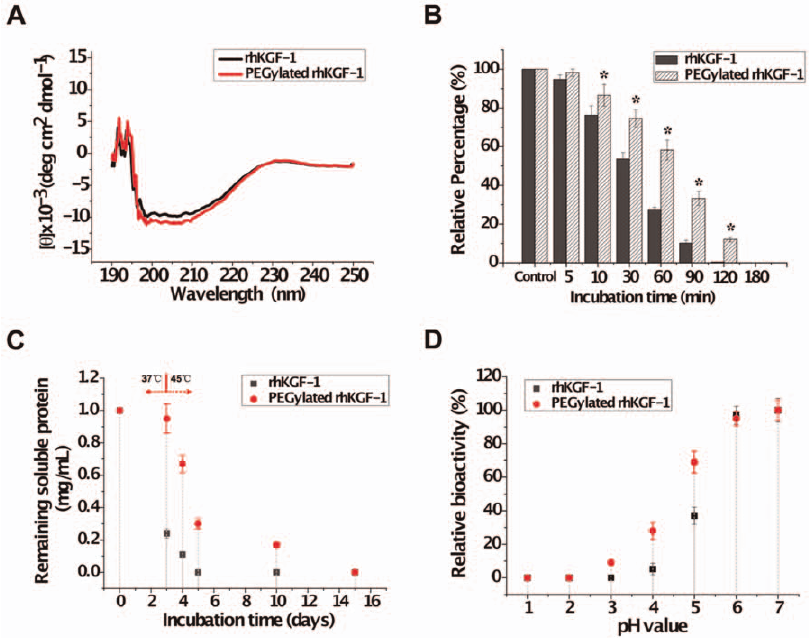
Figure 5. The effect of solid-phase PEGylation on the structural integrity and stability of rhKGF-1. Panel A. Far-UV CD spectra of non- PEGylated (black line) and solid-phase PEGylated rhKGF-1 (red line). The ellipticities are reported as mean residue ellipticity (MRE) (deg cm 2 dmol 2 1 ). Panel B. Effect of PEGyaltion on the proteolytic stability of rhKGF-1. PEGylated and intact rhKGF-1 were incubated with trypsin with a molar ratio of 10/1 (protein/trypsin) at 37 u C for the indicated periods of times. Trypsin-treated rhKGF-1 was examined for the protein integrity by SDS-PAGE. The bands representing PEGylated and intact rhKGF-1 were quantified by densitometry scanning. The band densities of non-trypsin-treated intact and PEGylated rhKGF-1 are considered as 100% (indicated as control), while the band densities of trypsin-treated PEGylated or intact rhKGF-1 are presented as relative percentage to the control. *, p , 0.05 vs the corresponding intact rhKGF-1 group. Panel C. Kinetic plots of remaining soluble non- PEGylated rhKGF-1 (black square) and PEGylated rhKGF-1 (red circle). The soluble protein concentration was determined by Bicinchoninic acid (BCA) kit. Samples were first incubated at 37 u C for 3 days and then transferred to 45 u C for the rest of the experiments. Pane D. Effect of pH on in vitro bioactivity of non-PEGylated rhKGF-1 (black square) and PEGylated rhKGF-1 (red circle).